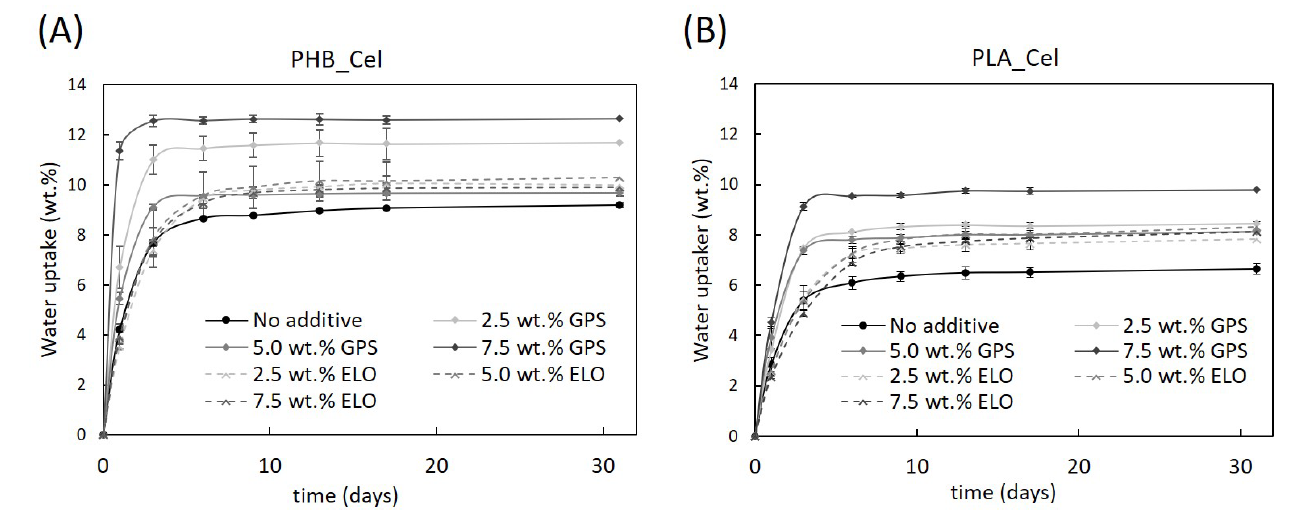
Figure 7. Water uptake capacity of the PHB- ( A ) and PLA-based composites ( B ) without additives and with different loads of GPS and ELO additives (the lines are for visual guidance only).